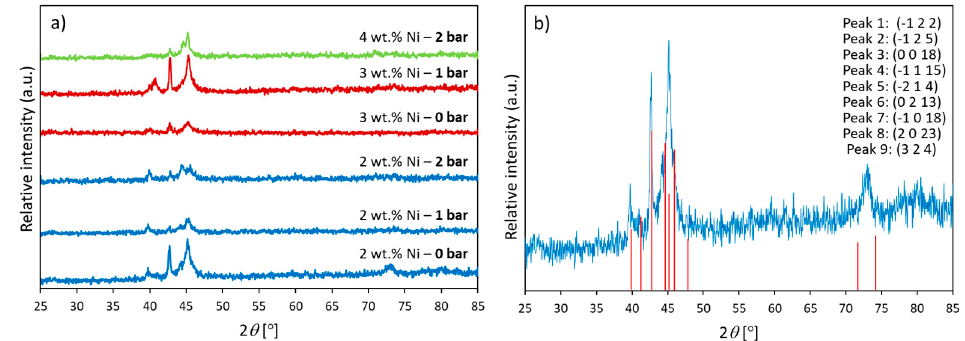
Figure 8. XRD analysis: ( a ) comparison of diffraction patterns from different samples, and ( b ) identification of peaks by comparing pattern of sample with 2 wt.% Ni produced at 0 bar relative pressure with peak positions and relative intensities of the reference pattern. The associated crystallographic planes are indicated in order of peak appearance from the lowest to highest diffraction angle.